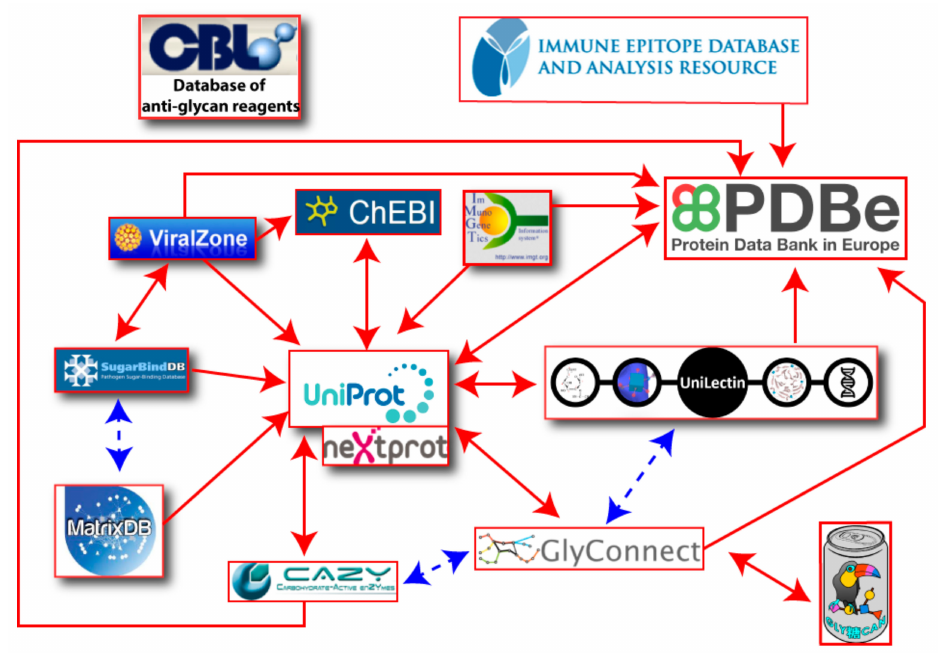
Figure 2. One- or two-way referencing between online databases. Arrows represent links between di ff erent resources and are double edged if links are reciprocal. Blue dotted lines represent future links that will strengthen the framework of databases.